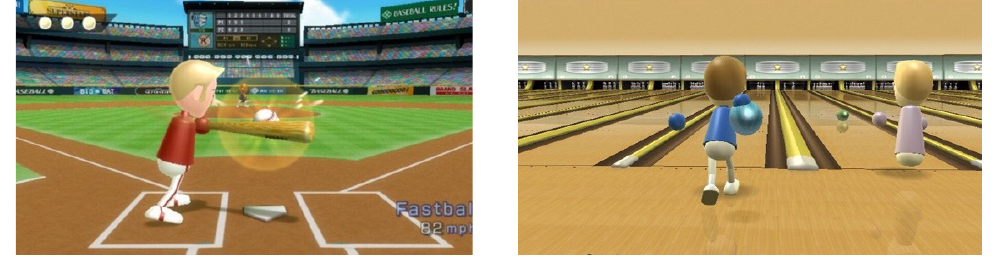
Fig. 7. Screen captures of Wii Sports : Baseball on the left, and Bowling on the right ( in https://www.nintendolife.com/games/wii/wii_sports/screenshots/